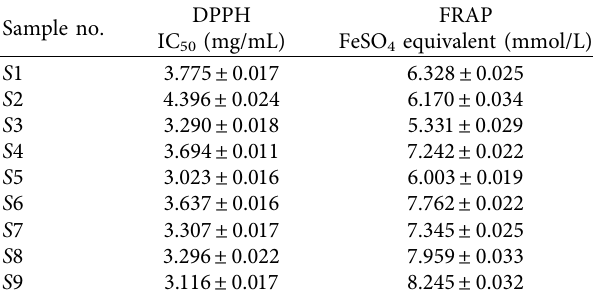
Table 7: The results of antioxidant activities ( x ± SD, n � 3). Sample